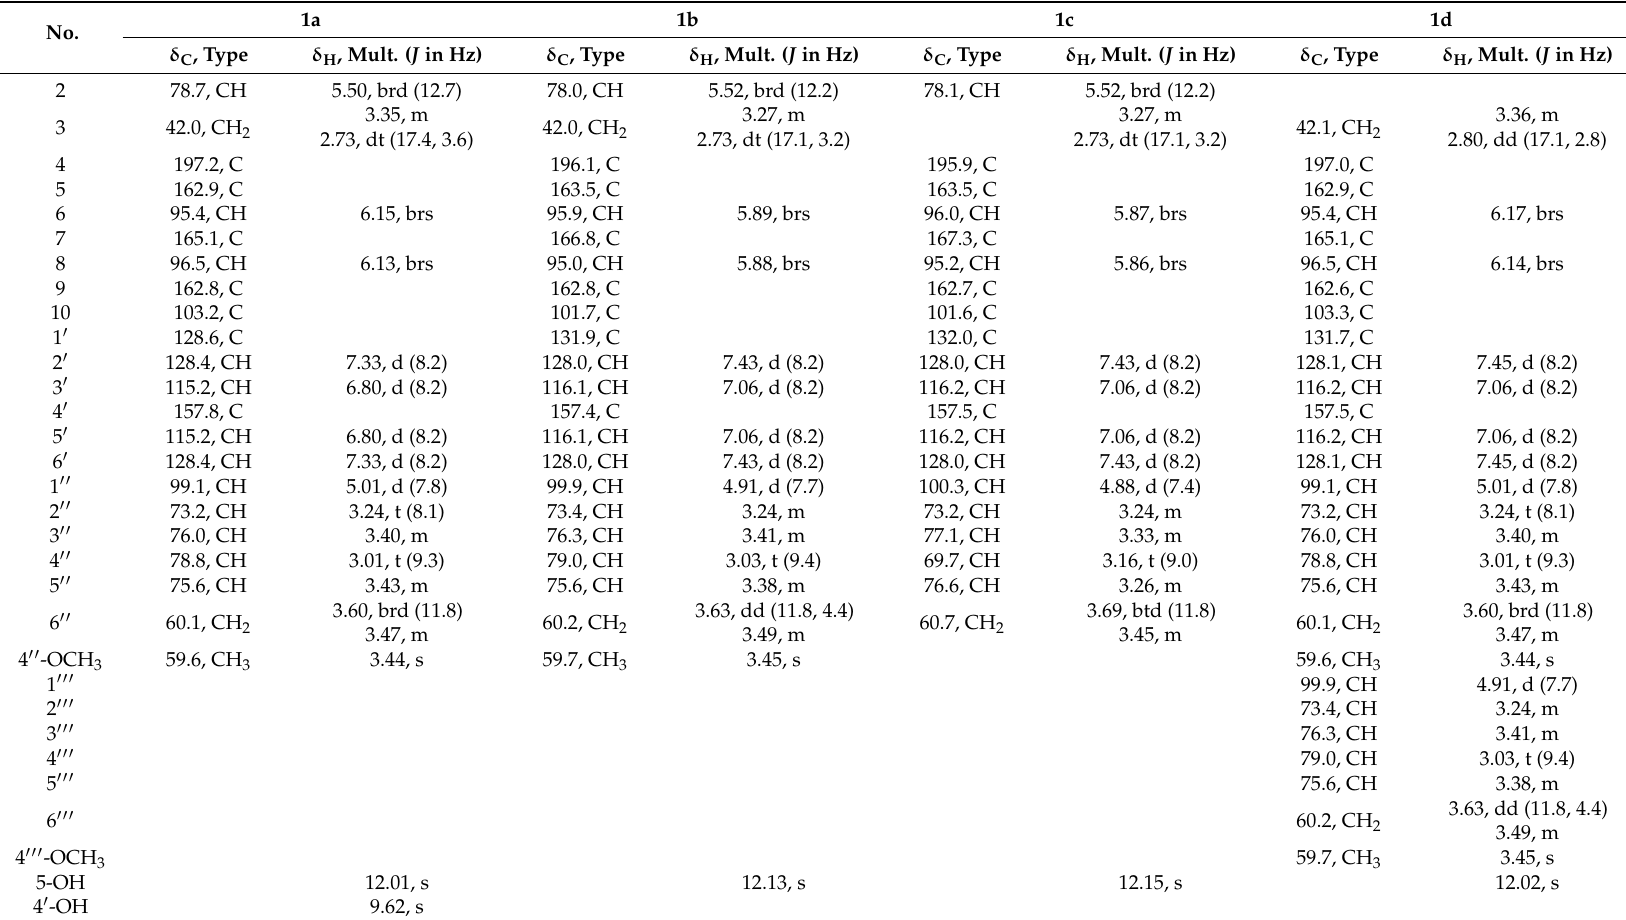
Table 1. 1 H- (600 MHz) and 13 C-NMR (150 MHz) Data of 1a , 1b , 1c and 1d in DMSO- d